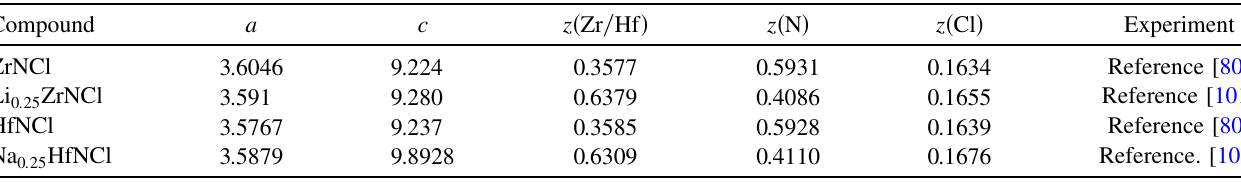
TABLE II. The crystal structures of ZrNCl, Li ZrNCl , HfNCl, and Na HfNCl used in our calculations. The atomic positions are 0 : 25 0 : 25 Zr = Hf , [0, 0, z ð Zr = Hf Þ ] and [ 2 = 3 , 1 = 3 , (cid:1) z ð Zr = Hf Þ ]; N, [0, 0, z ð N Þ ] and [ 2 = 3 , 1 = 3 , (cid:1) z ð N Þ ]; and Cl, [ 1 = 3 , 2 = 3 , z ð Cl Þ ] and [ 1 = 3 , 2 = 3 , (cid:1) z ð Cl Þ ]. Note that in the space group P (cid:4)3 m 1 , the atomic positions are shifted to Zr = Hf , [ 2 = 3 , 1 = 3 , z ð Zr = Hf Þ ] and [ 1 = 3 , 2 = 3 , (cid:1) z ð Zr = Hf Þ ]; N, [ 2 = 3 , 1 = 3 , z ð N Þ ] and [ 1 = 3 , 2 = 3 , (cid:1) z ð N Þ ]; and Cl, [0, 0, z ð Cl Þ ] and [0, 0, (cid:1) z ð Cl Þ ]. Here, we stick to the notation for the experimental